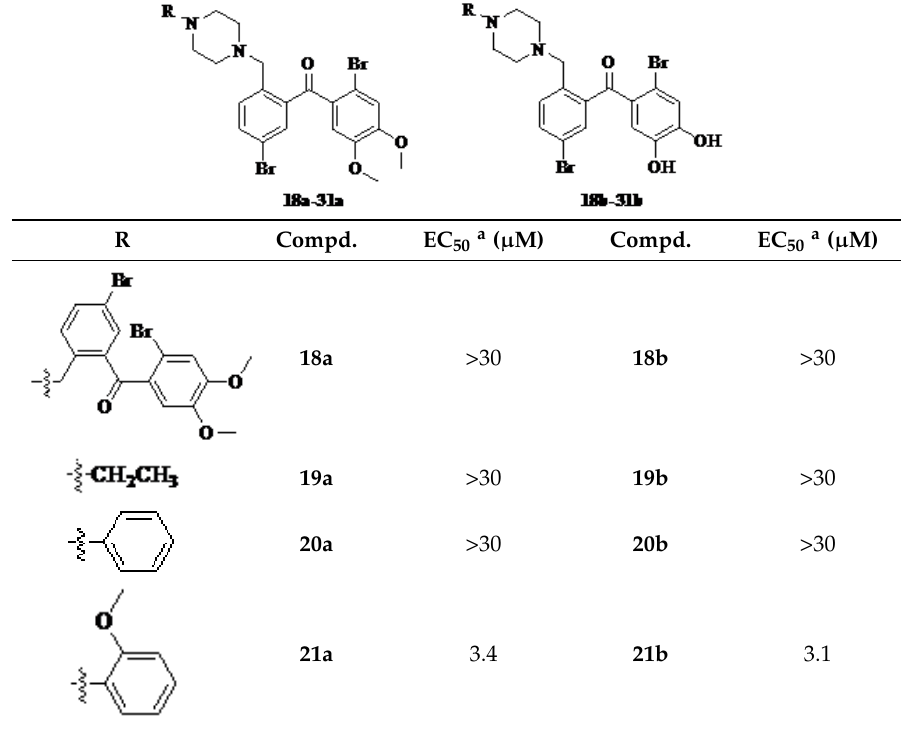
Table 2. Structures of piperazine compounds 18a – 31a , 18b – 31b and their cytoprotective activity against H 2 O 2 induced injury in EA.hy926 cells.